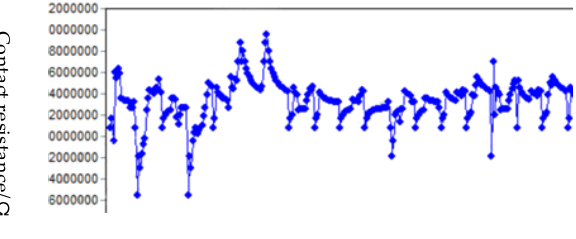
Figure 16. Statistics of contact resistance.